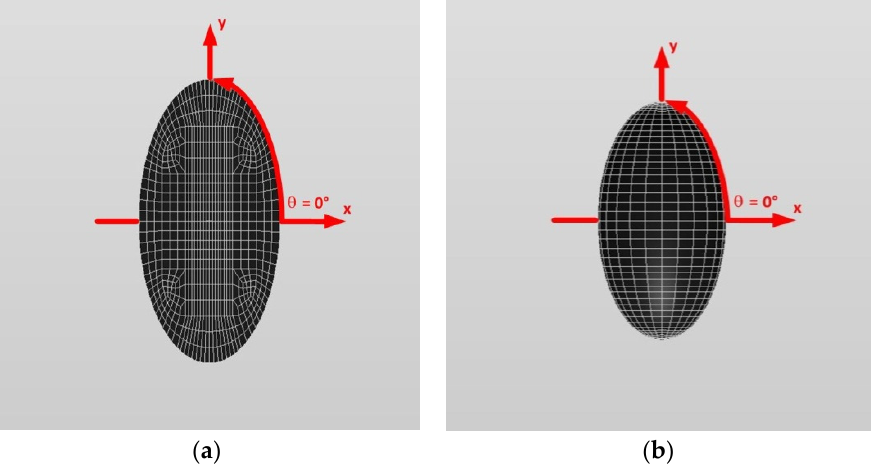
Figure 10. A typical discretized prolate spheroidal model (a/b = c/b = 0.5) in the volume integral equation method (VIEM). ( a ) An inside view of a prolate spheroidal model. ( b ) A prolate spheroidal model.